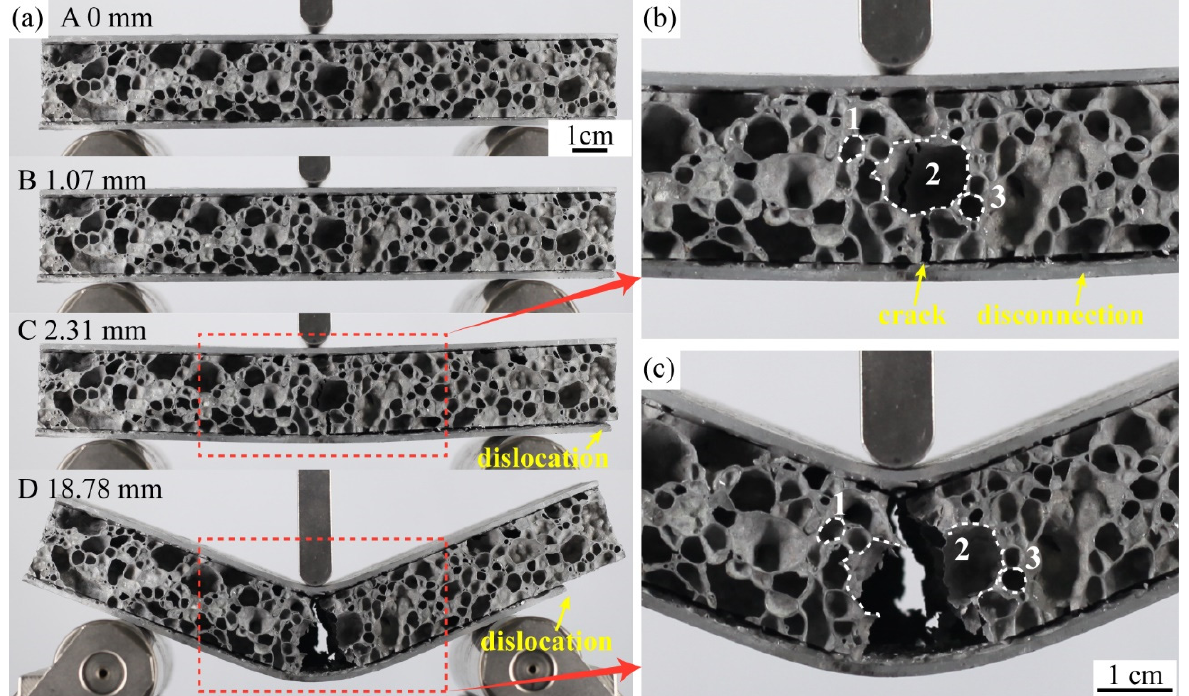
Figure 14. (a) The sequence of images shows the three-point bending test of glued AFS, ( b ) displacement is 2.31 mm, ( c ) displacement is 18.78 mm.